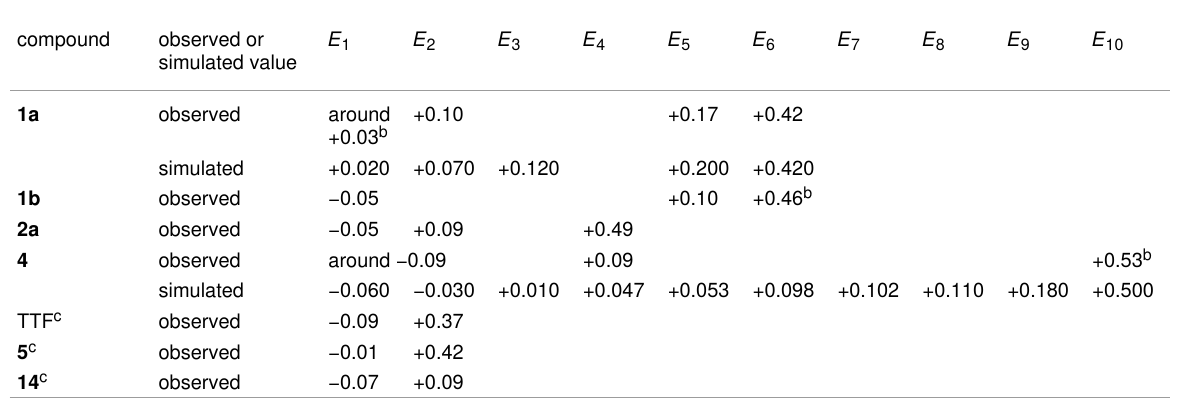
Table 2: Redox potentials of 1 , 2a , 4 , and related compounds a .